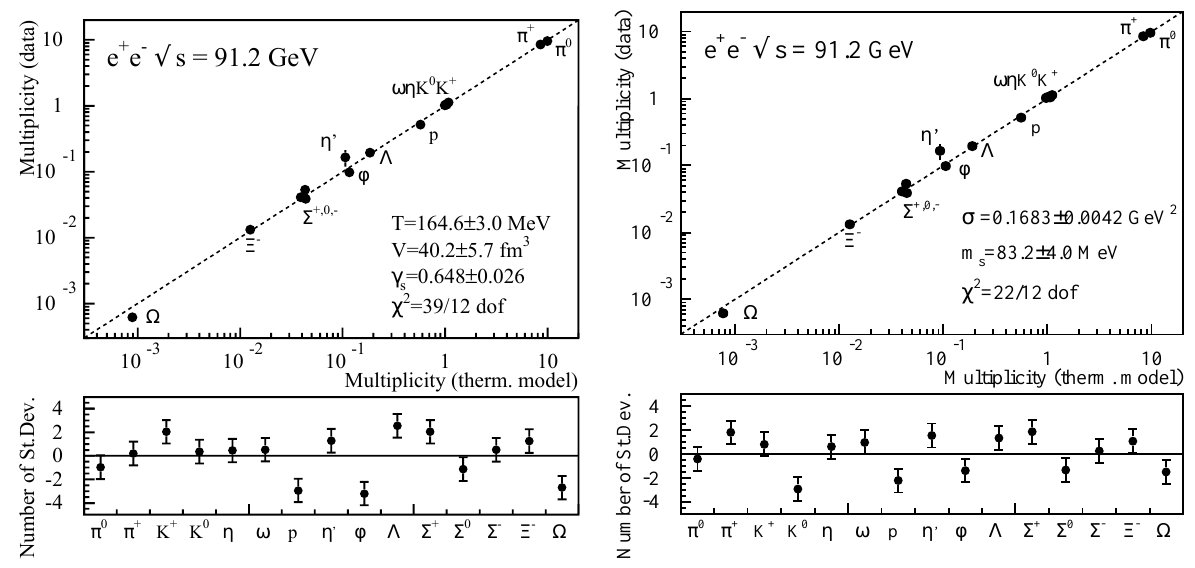
Figure 4. Comparison between the measured and fitted multiplicities of long-lived hadronic species √ s = 91.25 GeV. ( Left ): statistical hadronization model with one temperature. in e + e − collisions at ( Right ): Hawking–Unruh radiation model. See